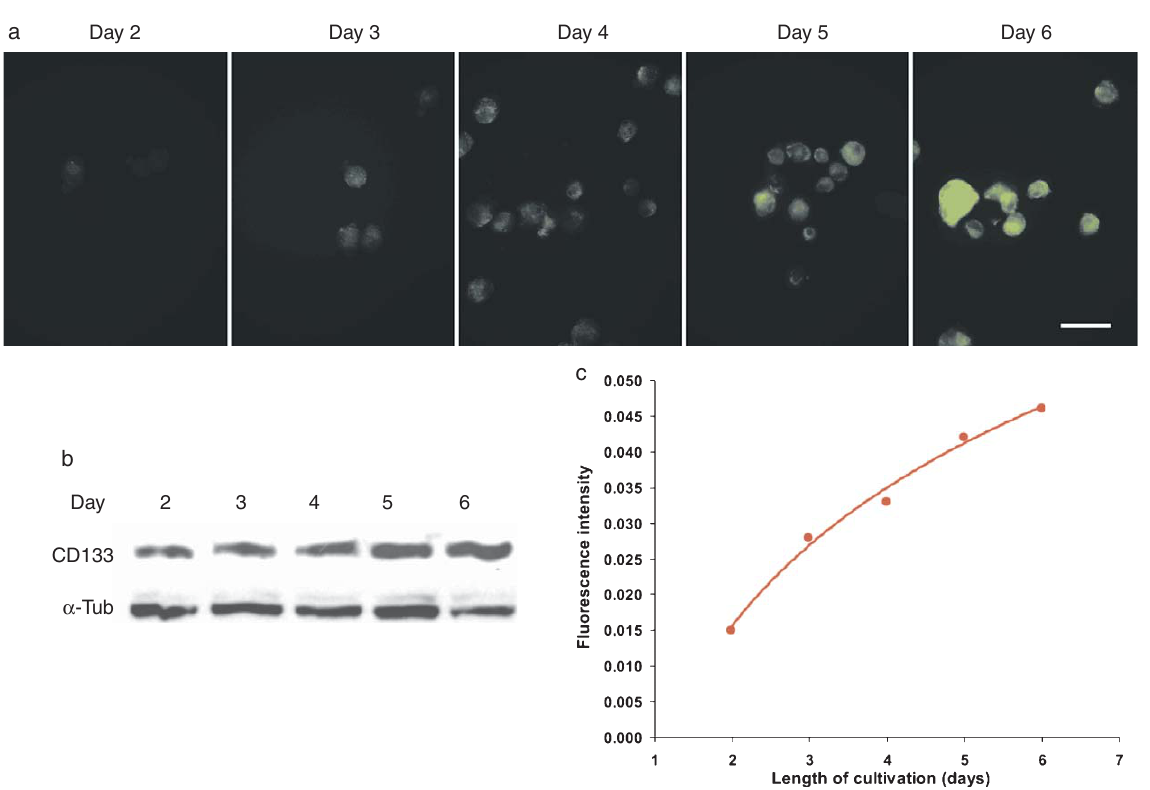
Fig. 5. CD133 expression changes in the rhabdomyosarcoma cell line NSTS-11 during a six-day cultivation. Cell suspensions were stained against CD133 (green) by indirect immunofluorescence using a FITC-labeled secondary antibody and were simultaneously analyzed using a fluorescence microscope; bar 50 (cid:1) m (a) and by flow-cytometry (c). Fluorescence intensity (FI) is calculated as a quotient of difference; FITC-A log CD133 median fluorescence intensity (MFI) with FITC-A log Iso MFI, and FSC-A where: FITC-A log CD133 is calculated as the mean ( n =2) of medians FITC-A log in samples immunostained with rabbit polyclonal anti-CD133 primary antibody, FITC-A log Iso is calculated as a mean ( n =2) of medians FITC-A log in samples immunostained with rabbit polyclonal isotype control, FSC-A is calculated as a mean ( n =4) of medians FSC-A above mentioned all samples. FI=(FITC-A log CD133 – FITC-A log Iso ) / FSC-A. Immunoblot analysis of the CD133 expression